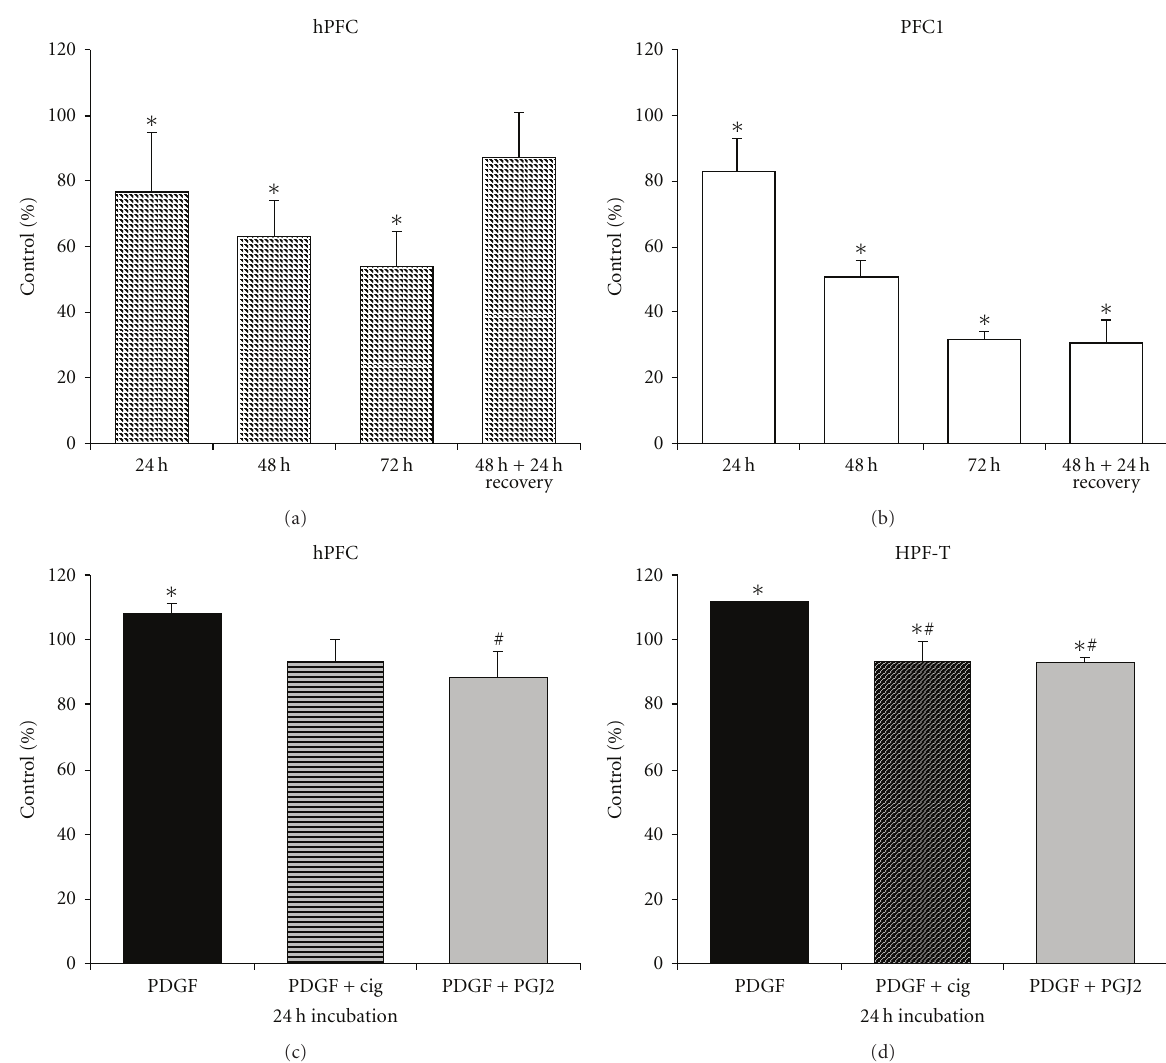
Figure 3: E ff ects of PPAR γ ligands on proliferation. (a) Time course of incubation of hPFC with 3.3 μ M ciglitazone. Proliferation decreases significantly ( ∗ ) over time. Reversibility was tested by washout of drug after 48h and incubation in fresh drug-free medium for further 24h, and the proliferation rate did not significantly di ff er from untreated cells. (b) Time course of incubation of PSC-1 cells with 3.3 μ M ciglitazone. Proliferation rates decreased significantly ( ∗ ) over time. The washout experiment did not show reversibility of ciglitazone- induced inhibition. (c) E ff ect of PPAR γ ligands on PDGF-stimulated proliferation in hPFC. Cells were incubated for 24h with platelet- derived growth factor (PDGF) at a concentration of 5ng/mL. One hour after the start of PDGF incubation, ciglitazone (cig, 3.3 μ M) or 15 Δ - prostaglandin J 2 (PGJ2, 5 μ M) was added. PDGF induced a significant growth stimulation. Ciglitazone treatment did not significantly inhibit this growth induction, but PGJ2 did. ( ∗ Significant versus control, # significant versus PDGF stimulation.) (d) E ff ect of PPAR γ ligands on PDGF-stimulated proliferation in HPF-T cells. Cells were incubated for 24 h with platelet-derived growth factor (PDGF) at a concentration of 5ng/mL. One hour after start of PDGF incubation, ciglitazone (cig, 3.3 μ M) or 15 Δ -prostaglandin J 2 (PGJ2, 5 μ M) was added. PDGF stimulated proliferation significantly, and both ciglitazone and 15 Δ -prostaglandin J 2 inhibited stimulated growth in transformed HPF-T cells. ( ∗ Significant versus control, # significant versus PDGF stimulation, n ≥